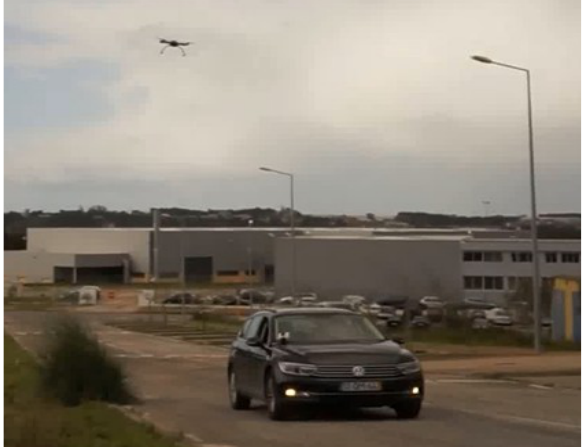
Figure 4: Preliminary tests of the mapKITE TV-to-UA virtual